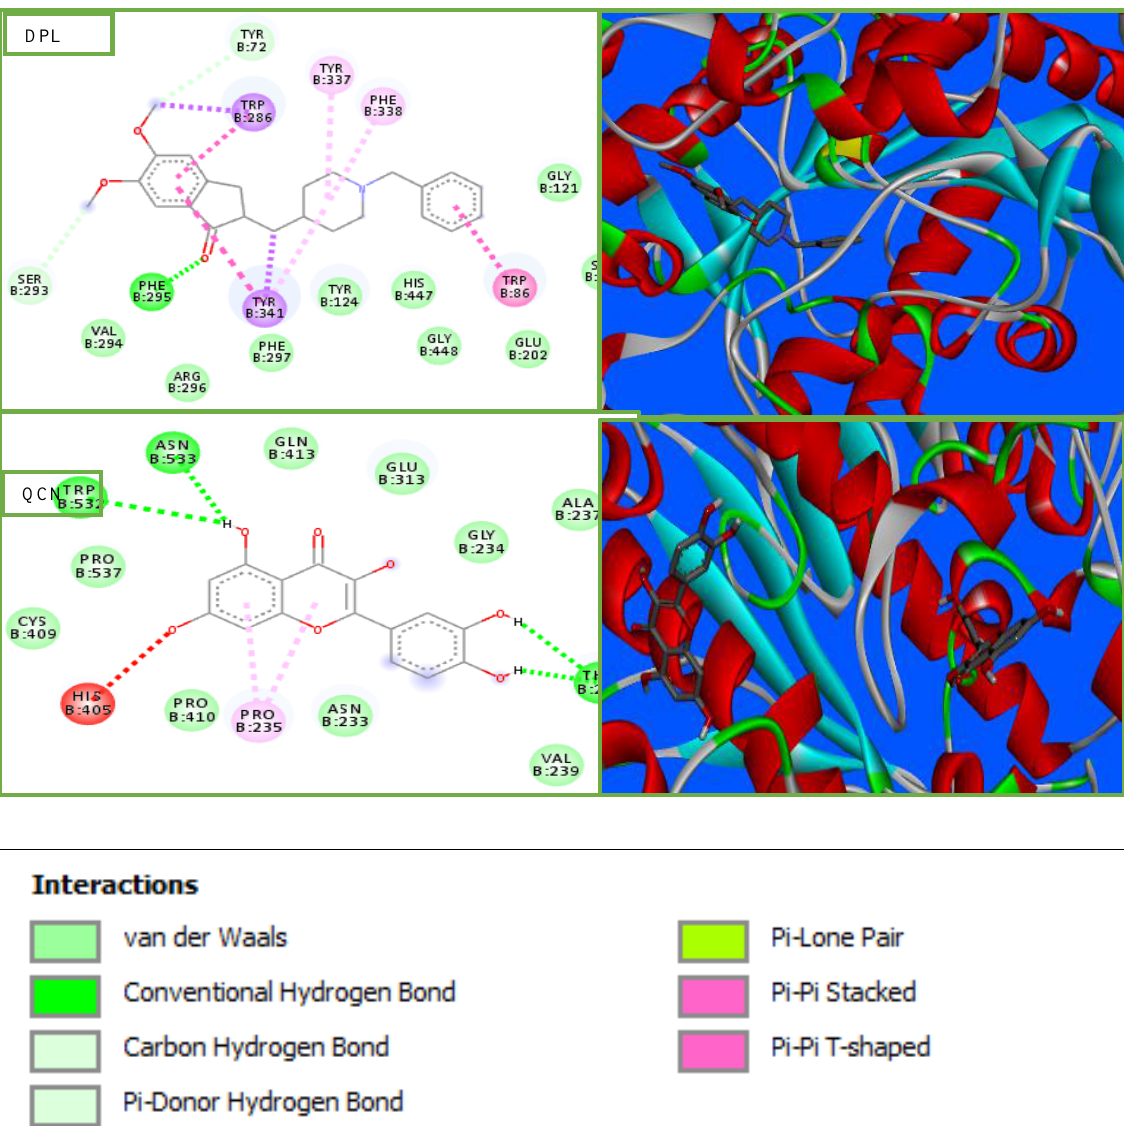
Figure 8. Amino acids interactions and 3D conformations of quercetin within the binding pocket of acetylcholinesterase. QCN = Quercetin, DPL =